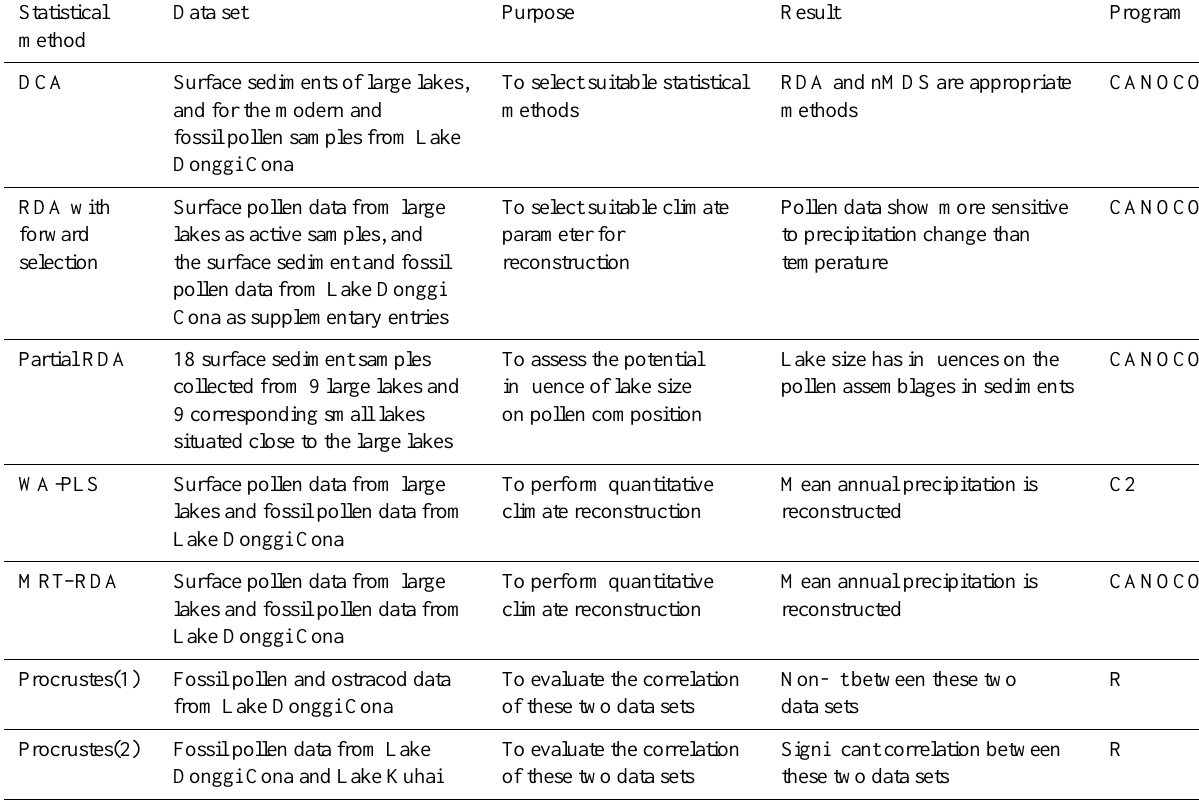
Table 3. Summary of statistical methods involved in this study, the employed data sets, the general purposes, the results and used